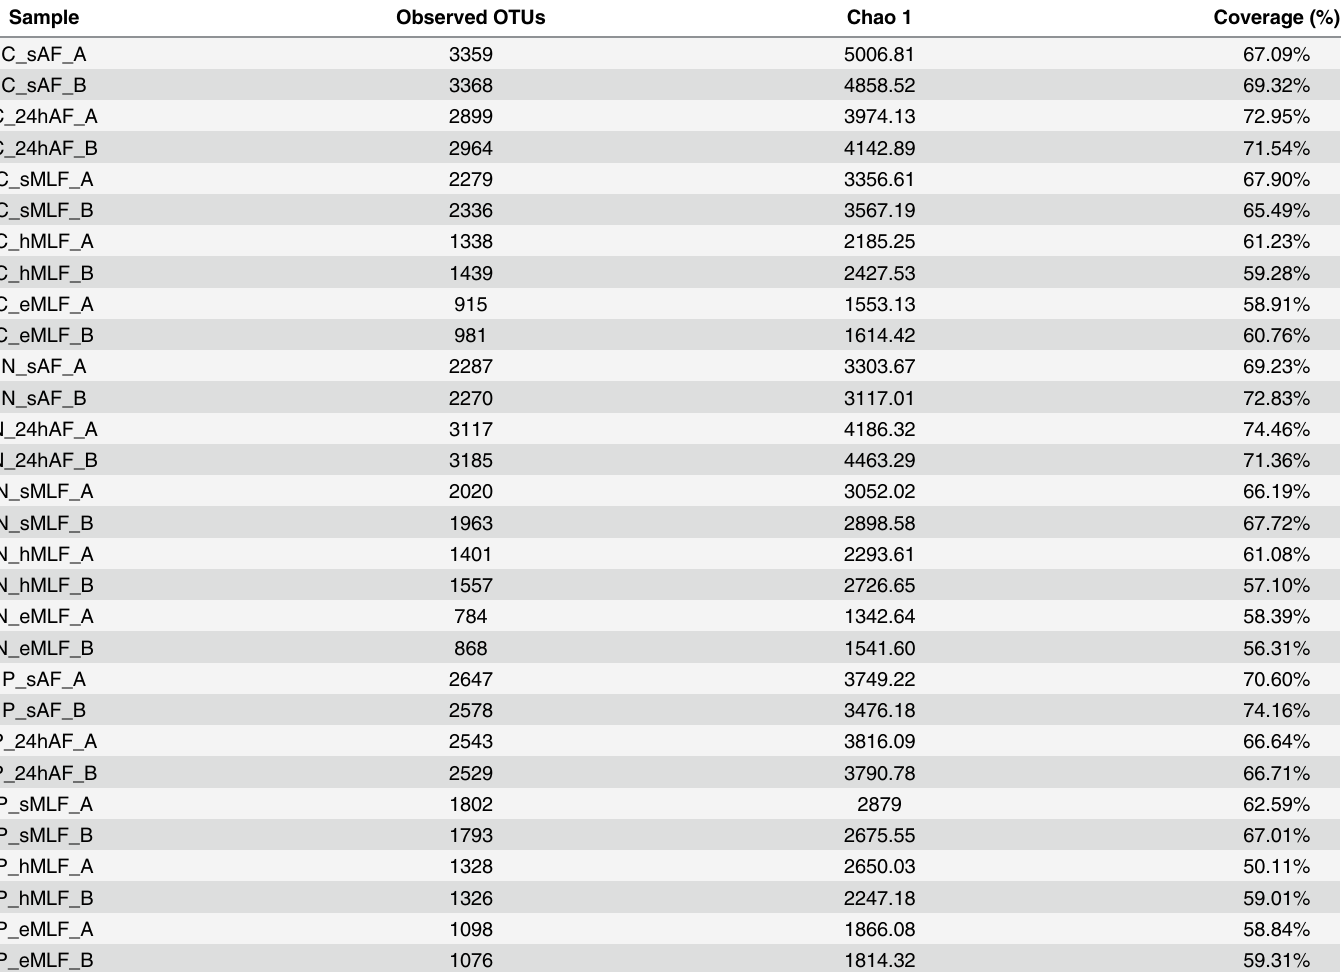
Table 1. The number of observed OTUs, the species richness estimator (Chao 1), and coverage (calculated from the ratio of observed OTUs and Chao 1) obtained for each sample and sequencing run (A or B). Sample Observed OTUs Chao 1 Coverage (%) 3359 5006.81 67.09% 3368